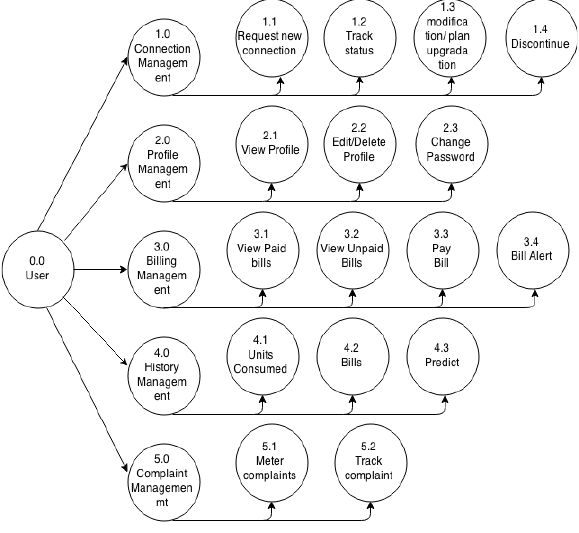
Figure 12. Profile Management for a user in Integrated